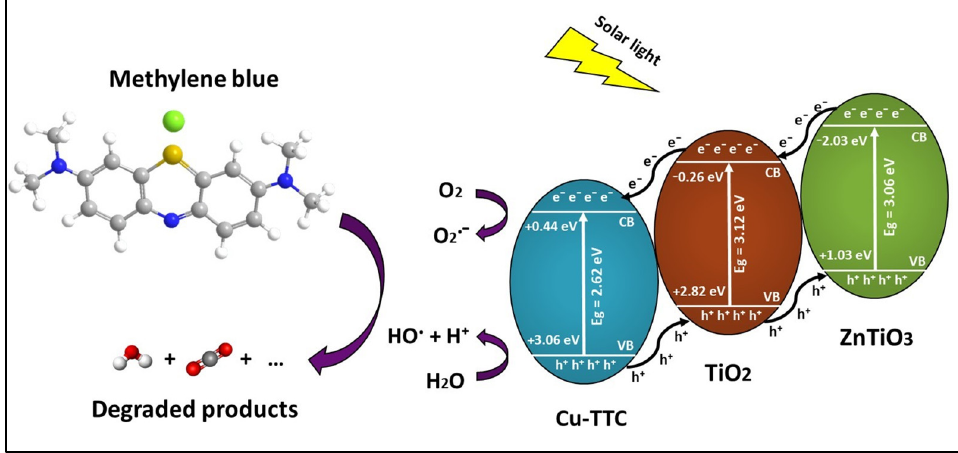
Figure 13. Schematic of electron–hole separation and transportation on the interface Cu- TTC/ZnTiO 3 /TiO 2 .